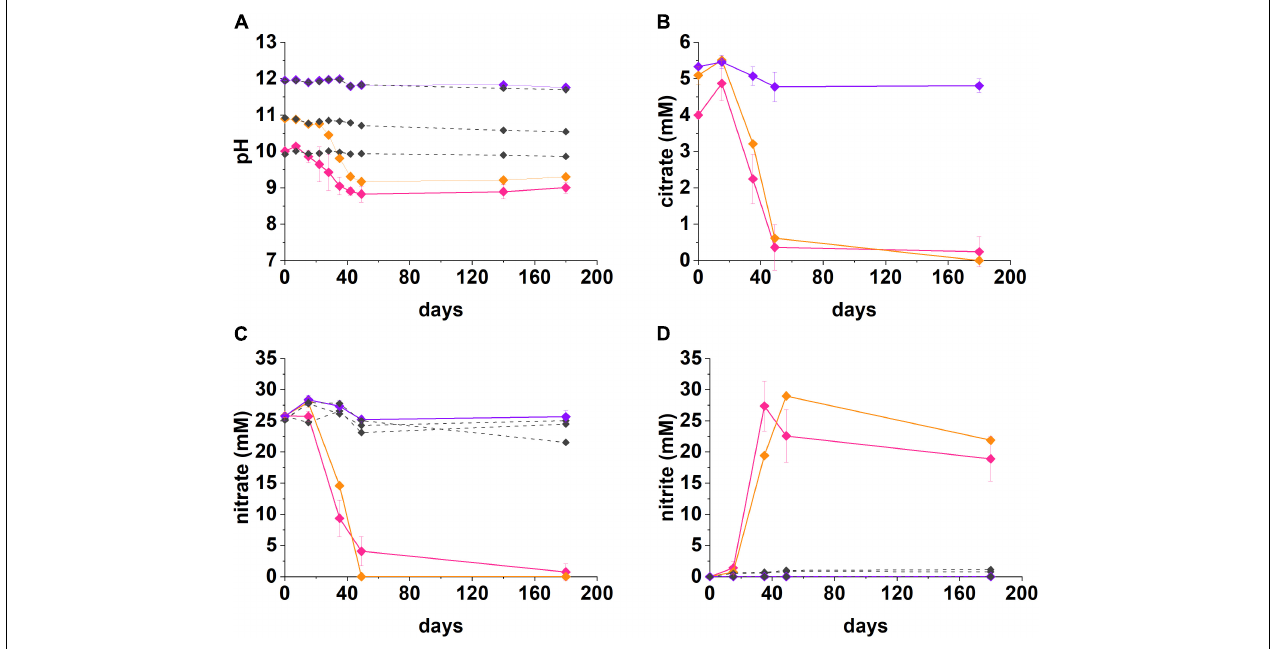
FIGURE 1 | Geochemical data for nitrate-reducing experiments. The pH (A) , citrate (B), nitrate (C), and nitrite (D) data from anaerobic, high pH microcosms incubated for up to 200 days at 20 ◦ C in the dark are presented (pH 10—pink, pH 11—orange, pH 12—purple, no-citrate control—dashed gray). The errors are shown and represent 1 SD on triplicate